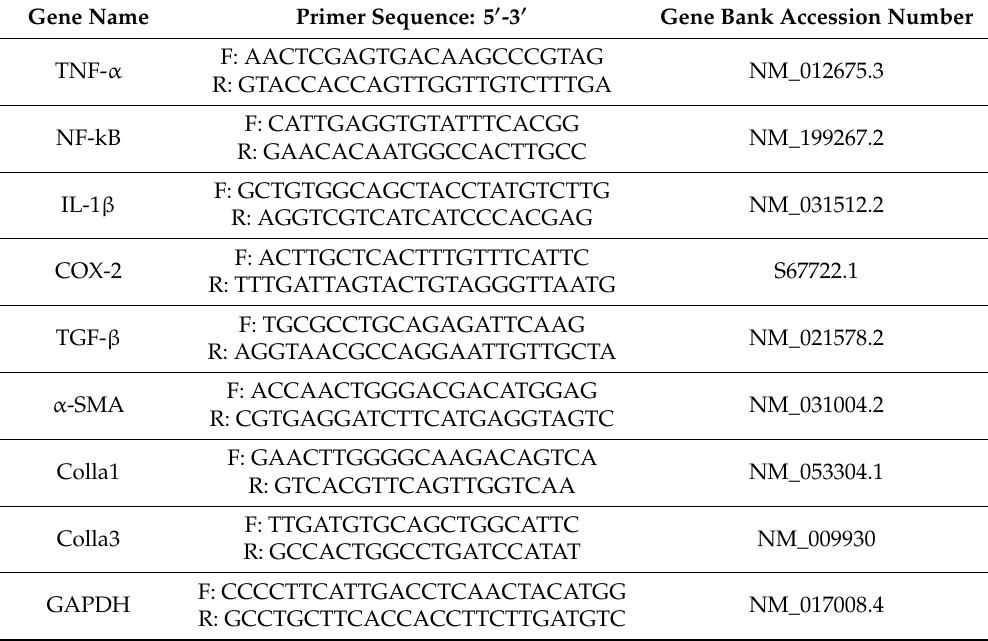
Table 1. Primer sequences used for reverse-transcriptase-polymerase chain reaction